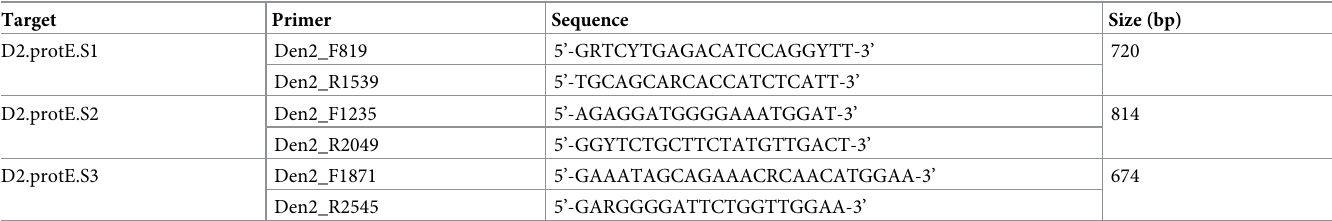
Table 1. Primers targeting DENV-2 envelope gene sequence.